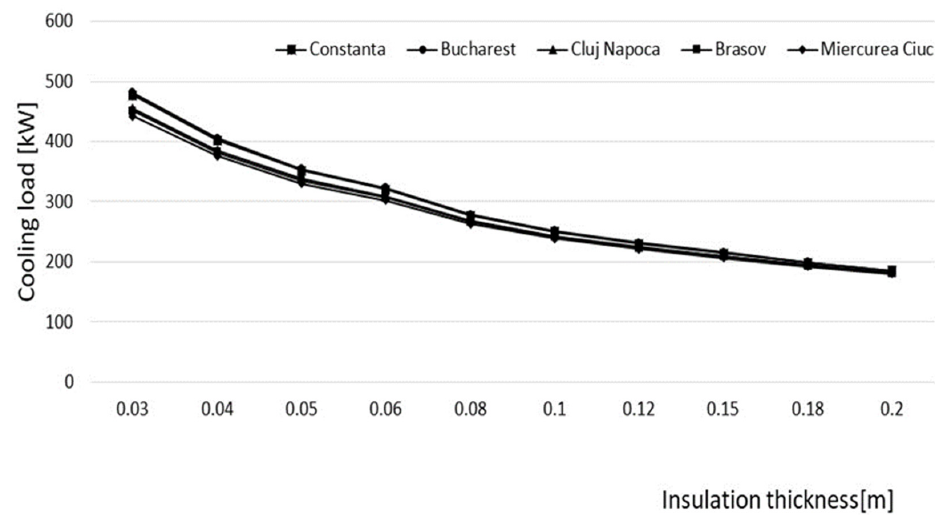
Figure 3. Total cooling load required for frozen storage.